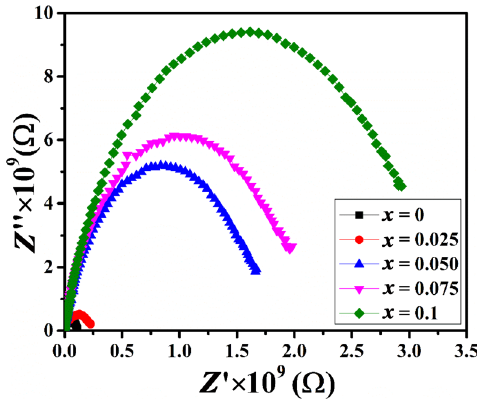
Fig. 13 Nyquist plots for Mn 0.5 Zn 0.5 Gd x Fe 2– x O 4 ( x = 0, 0.025, 0.050, 0.075, and